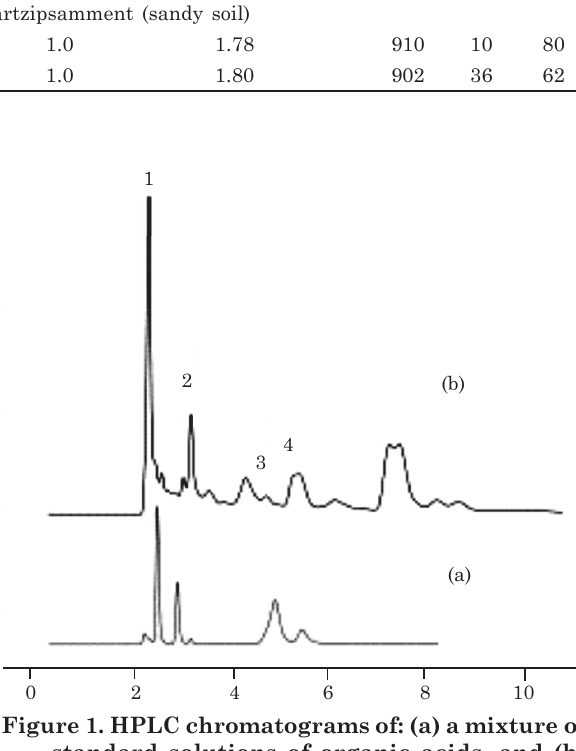
Figure 1. HPLC chromatograms of: (a) a mixture of standard solutions of organic acids, and (b) vinasse sample. Peaks identified: (1) malic acid, (2) lactic acid, (3) citric acid, and (4) succinic